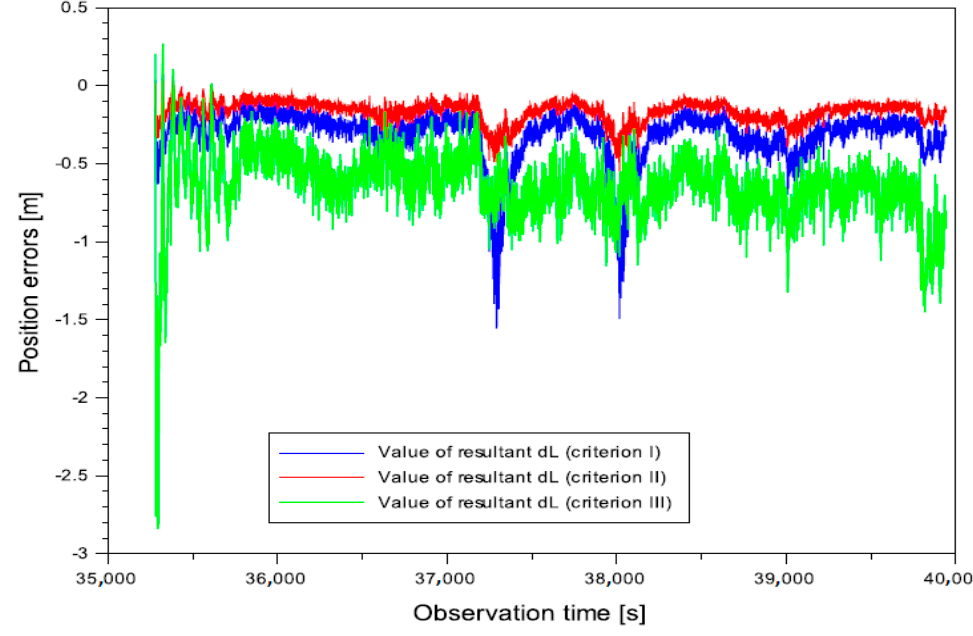
Figure 22. The values of resultant position errors dL .